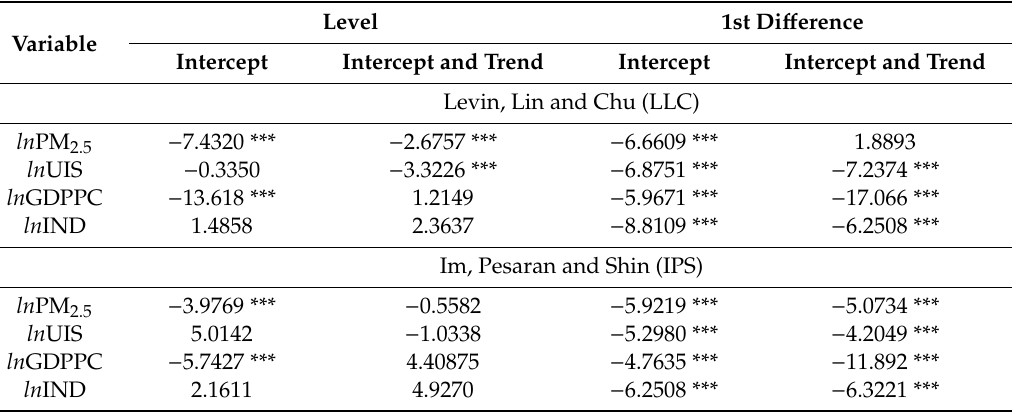
Table 2. Panel unit root test results.